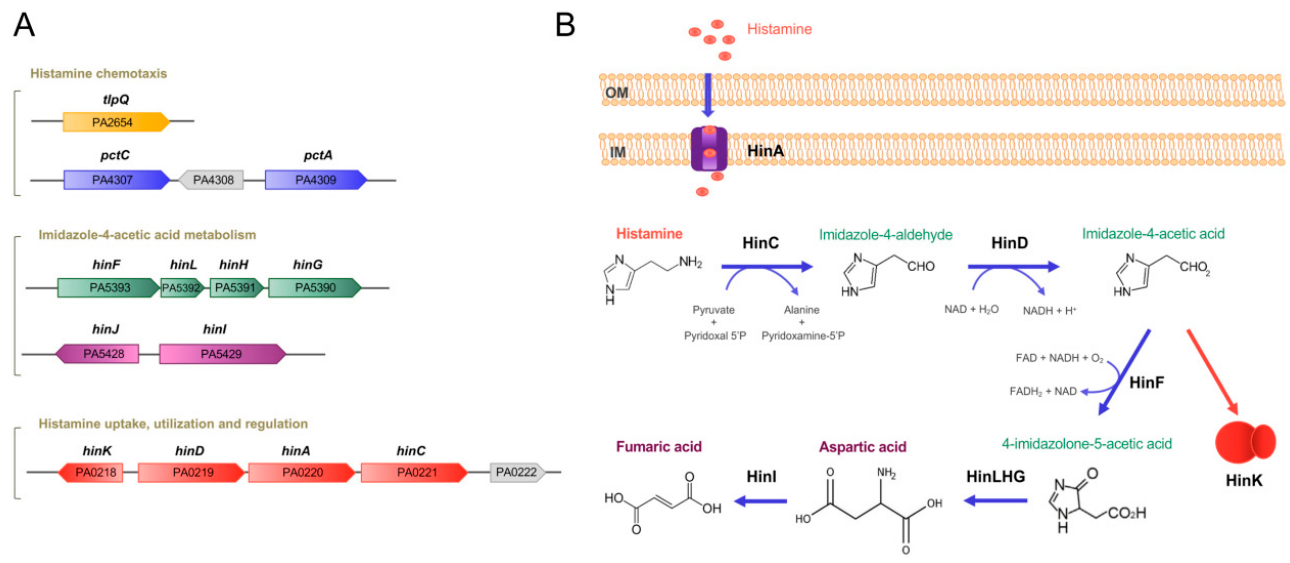
Figure 1. Genes and proteins involved in histamine metabolism, transport, regulation and chemotaxis in P. aeruginosa PAO1. ( A ) Genetic organization of genes. ( B ) The proposed histamine catabolic pathway. Data are based on [18,23,24].